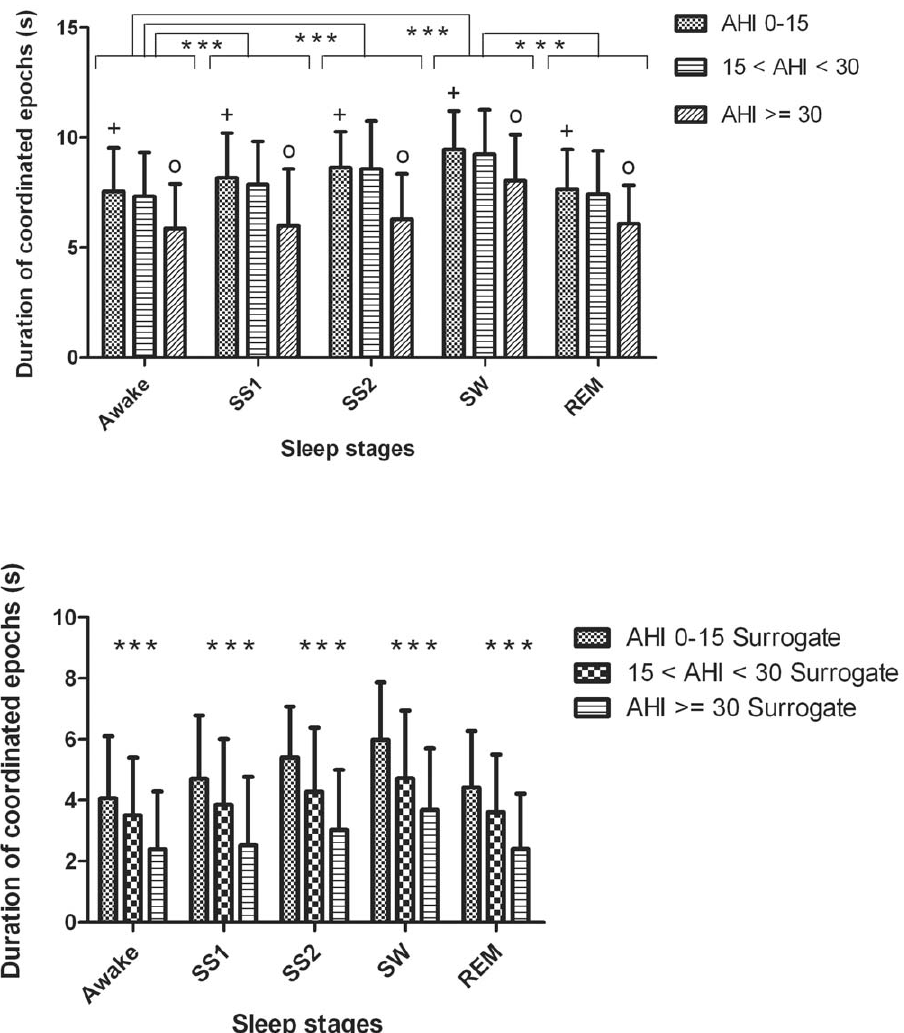
Figure 4. Group and sleep related comparison of average duration of coordinated epochs in seconds (AvDurCordn, mean ± SD) using original (upper panel) and surrogate data (lower panel) from abdominal signal. The circle indicates that the differences in AvDurCordn between the moderate and severe OSA groups are significant ( p , 0.01) for all the sleep stages. Similarly, the plus indicates the significant differences ( p , 0.001) in AvDurCordn between no/mild and severe OSA groups for all the sleep stages. *** (p , 0.0001) indicates the significant differences in AvDurCordn between different sleep stages as well as the original and surrogate data.